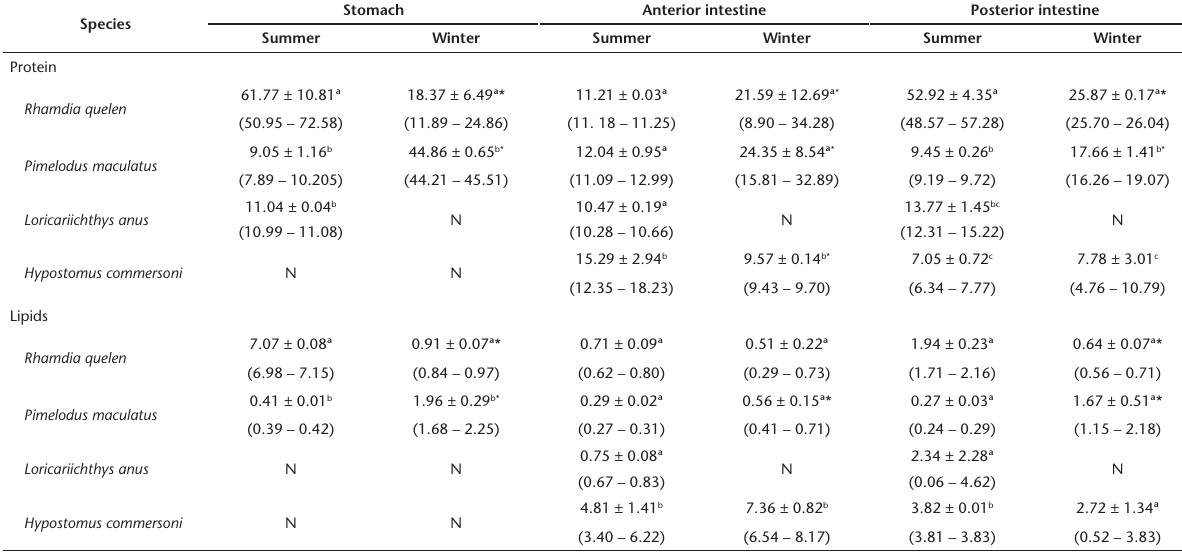
Table 1. Percentage and range (between parentheses) of protein and lipids (dry matter) in the content of the gastrointestinal tract of four teleost species collected in two